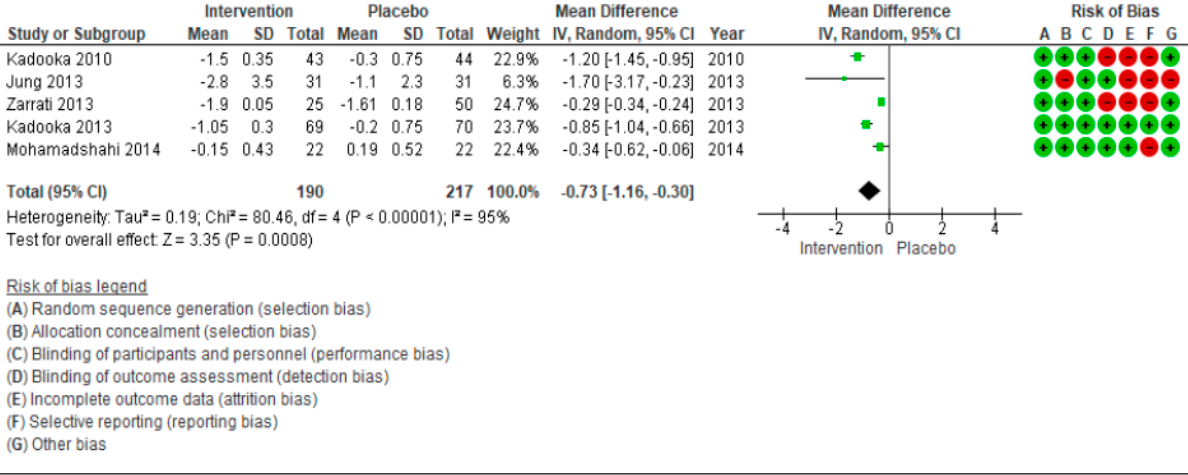
Figure 4. Forest plot for randomized controlled trials of probiotic supplementation included in hip circumference (cm) subgroup meta-analysis ( n = 621). The studies are listed by first author and year. IV = equation that can be estimated by inverse variance (linear, exponential). The square represents the measures of effect (i.e., an odd ratios) for each study; the area of each square is proportional to the study’s weight in the meta-analysis. The horizontal line represents the confidence interval CI) at the 95% level. The diamond represents the meta-analyzed measure of effect; the lateral points of diamond indicate CIs for this estimate. The vertical line represents no effects; if the CI for an individual study overlaps with this line, the given level of confidence for the effect size does not differ from no effect for that study. Risk of bias indicate the level of high and low risk associated with the article, with green signal for low risk and red for high risk of bias. The risk of bias was also evaluated for the 20 studies: It was considered as high and low risk according to seven different criteria. Green indicates the risk of bias to be low, while red indicates the risk of bias to be high. 4. Discussion The results of this meta-analysis show that probiotic supplementation significantly decreases the BMI ( − 0.73 kg/m 2 [ − 1.31, − 0.16], p = 0.01), WC ( − 0.71 cm [ − 1.24, − 0.19], p = 0.008), and HC ( − 0.73 cm [ − 1.16, − 0.30], p = 0.0008), but not the body weight ( − 0.26 kg